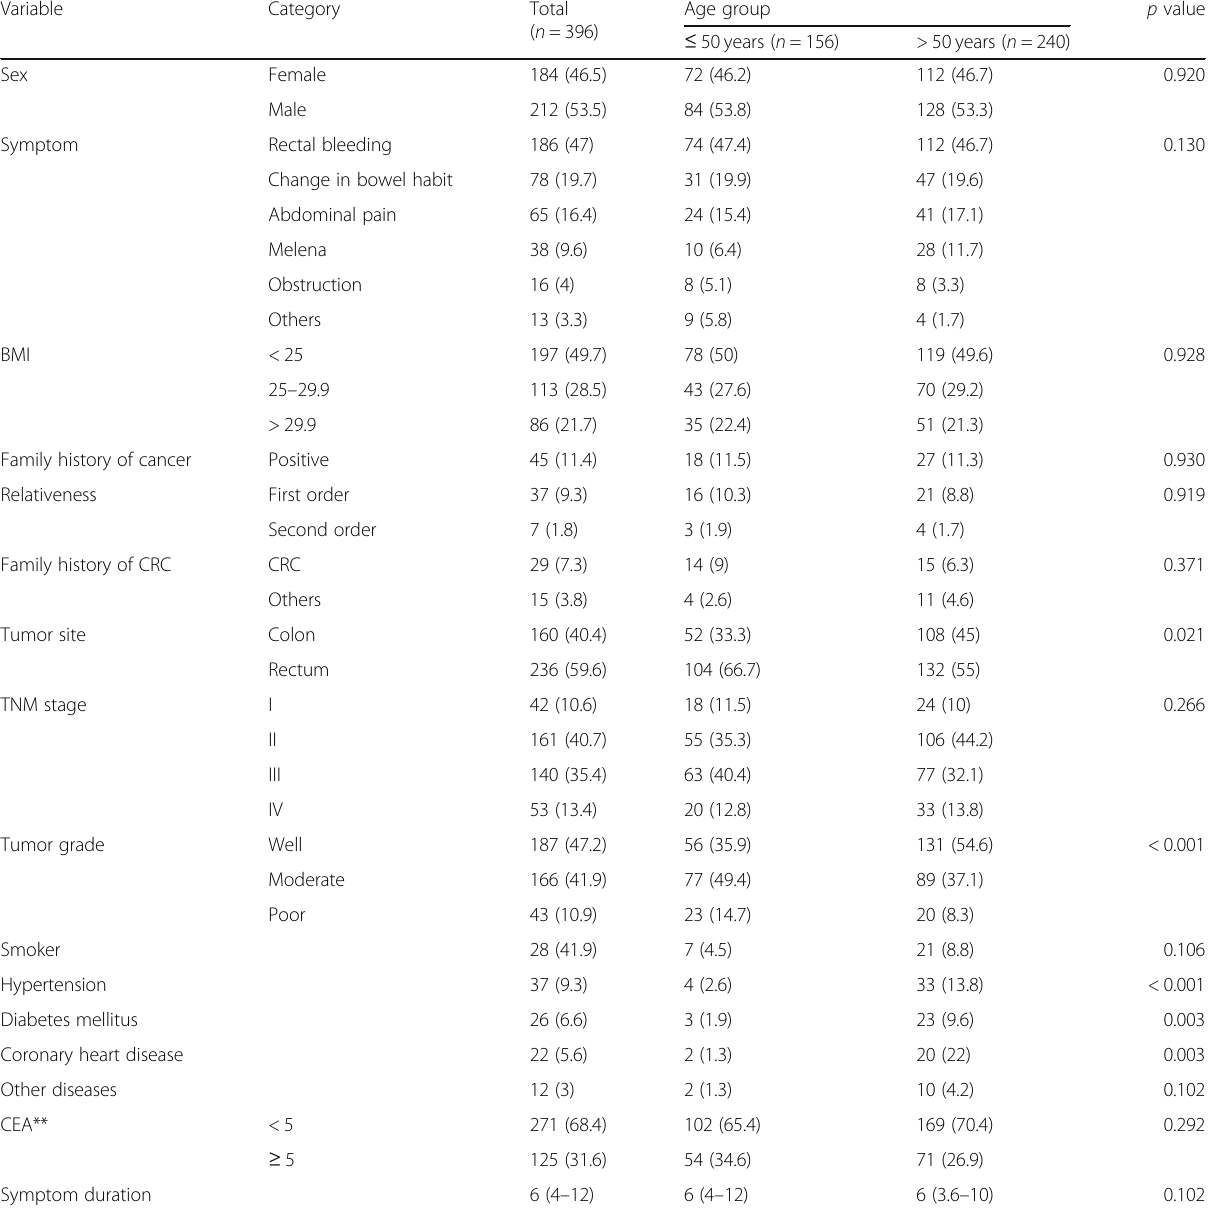
Table 1 Patients demographic and clinicopathological characteristics based on age group Variable